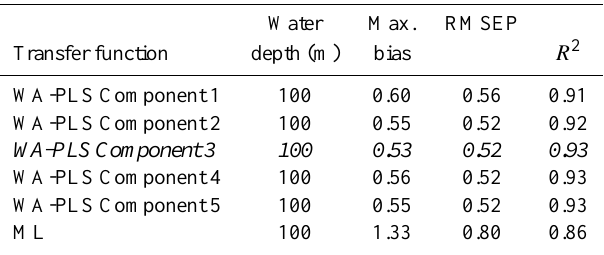
Table 3. Performance characteristics of transfer function models used to reconstruct palaeo-sSST of JM09-KA11-GC. Italics